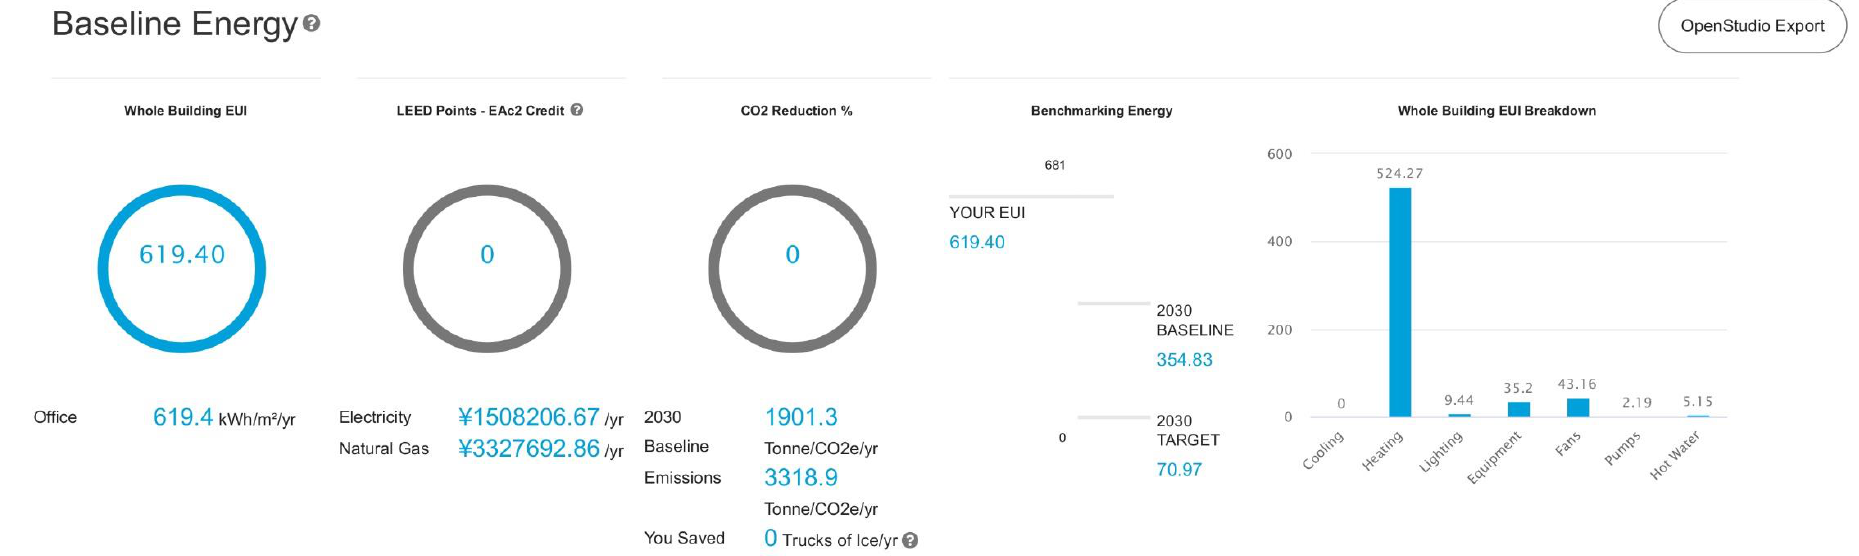
Figure A51. Zone 8-H Yushu, Qinghai (post-COVID-19 84% scenario).